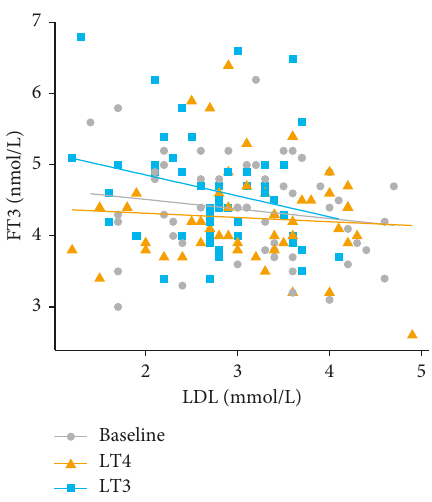
Figure 3: A scatter dot plot showing the association between serum levels of LDL cholesterol and levels of free T3 at baseline (grey line), after LT4 treatment (orange line), and after LT3 treatment (blue line).